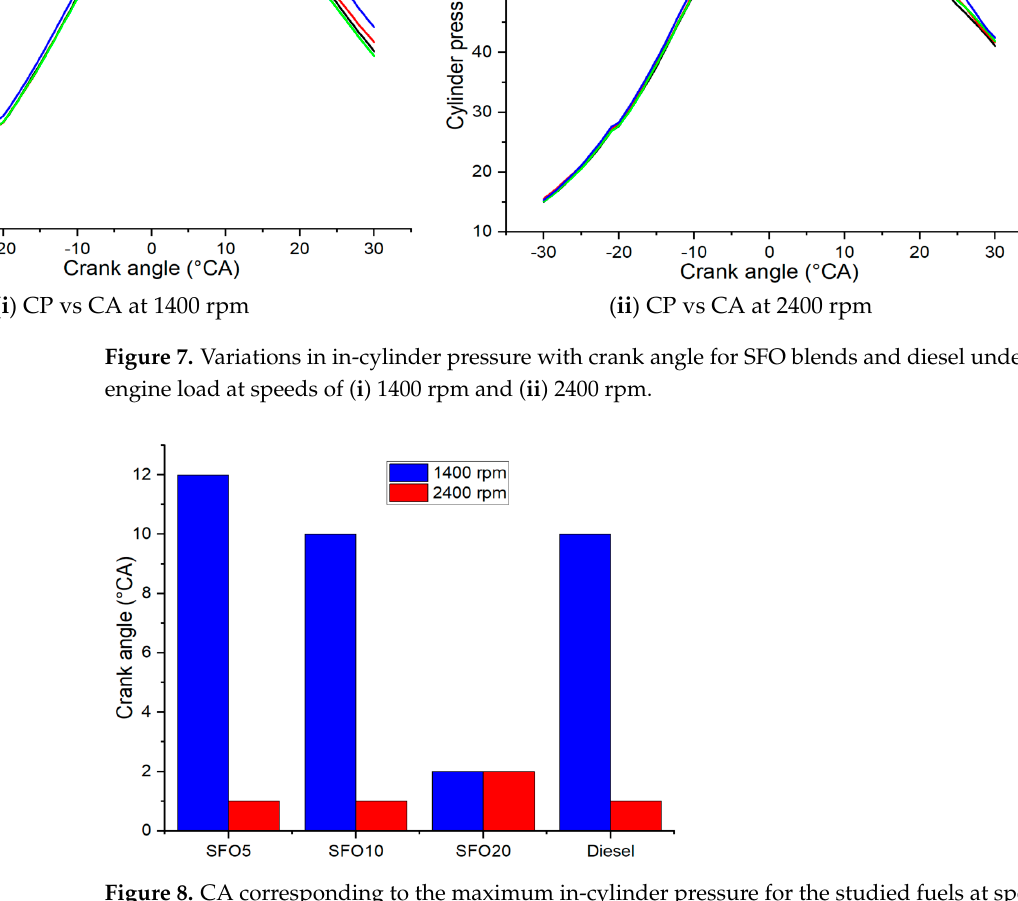
Figure 8. CA corresponding to the maximum in-cylinder pressure for the studied fuels at speeds of 1400 and 2400 rpm.